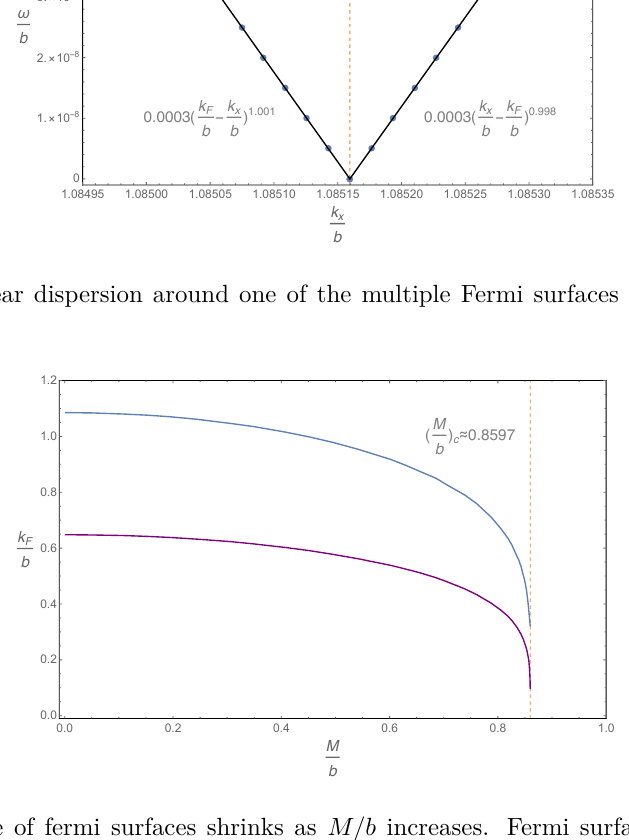
Figure 6 . The size of fermi surfaces shrinks as M/b increases. Fermi surfaces can exist in the nodal line semimetal phase as well as at the critical point while disappear in the trivial